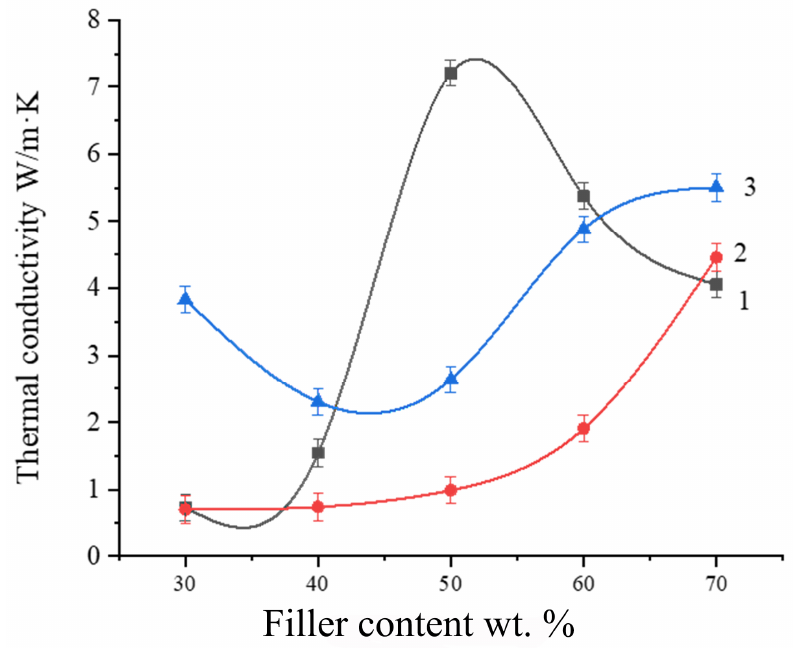
Figure 9. Thermal conductivity as function of filler content of PSU-based composite filled with NG (1); AG (2) and EG (3) at 25 °C.